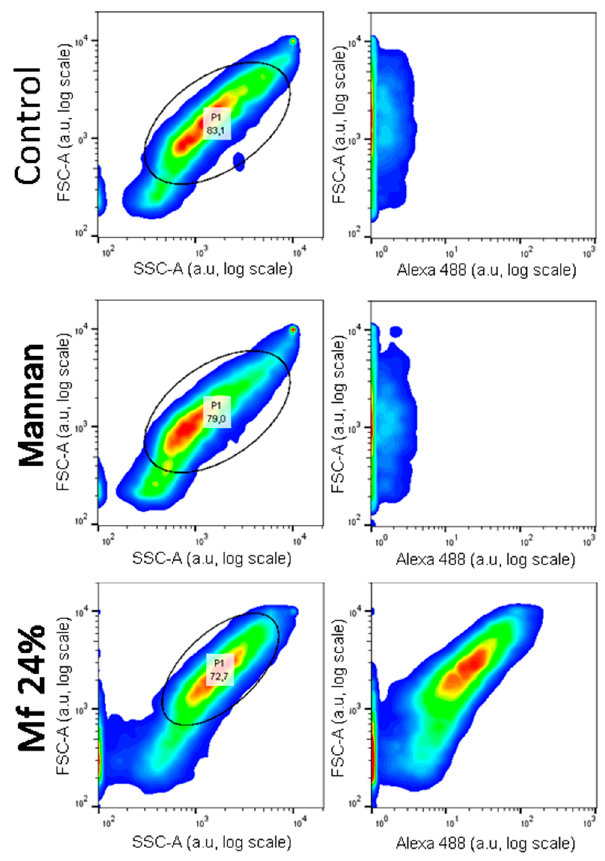
Figure 12. Flow cytometry analyses of hMBL-covered beads after 20 min in TBST Ca 2+ buffer (Control), Mannan (100 ng/mL), and Mf 24% (300 ng/mL) solutions. Comparing distributions from Mannan and Mf (Figure 13), the delimitation of the positive fluorescent population (F+) was possible and used to quantify the remaining fluorescence from beads during competition